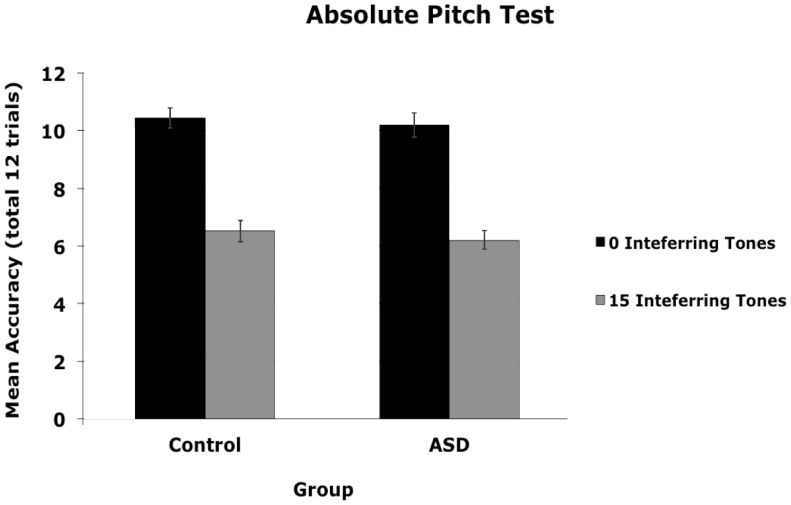
Mean accuracy for the Absolute Pitch Test by group.Mean number correct out of 12 for determining whether two tones had the same or different pitches when there were 0 or 15 interference tones, after removing the three ASD subjects with perfect scores in the 15-tone interference condition indicative of absolute pitch. Error bars represent standard error of the mean. There were no significant differences in performance between groups after removing these participants.